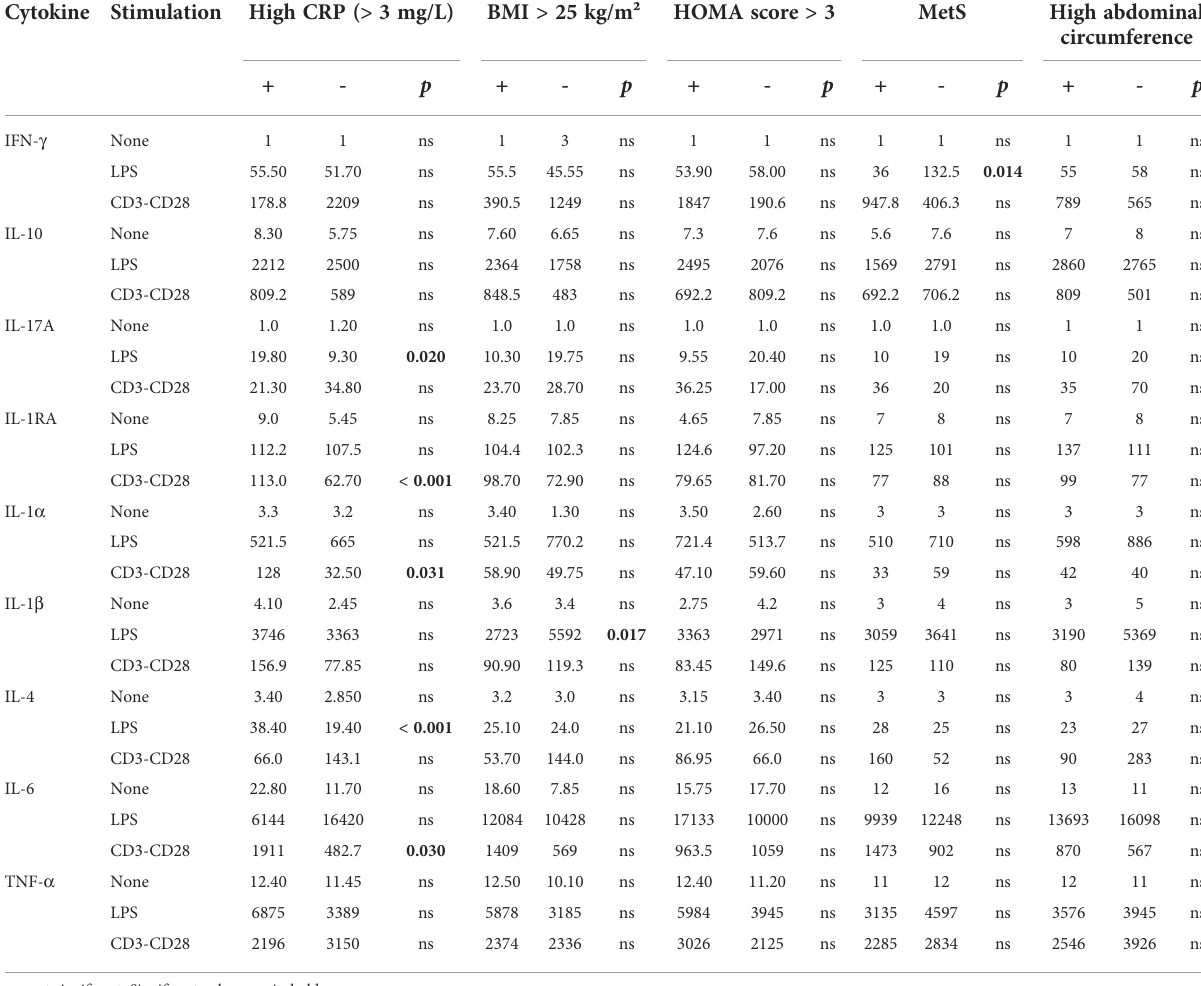
TABLE 2 Comparison of ex vivo cytokine production depending on MetS and related parameters in PsD patients (median; pg/mL). Cytokine Stimulation High CRP (> 3